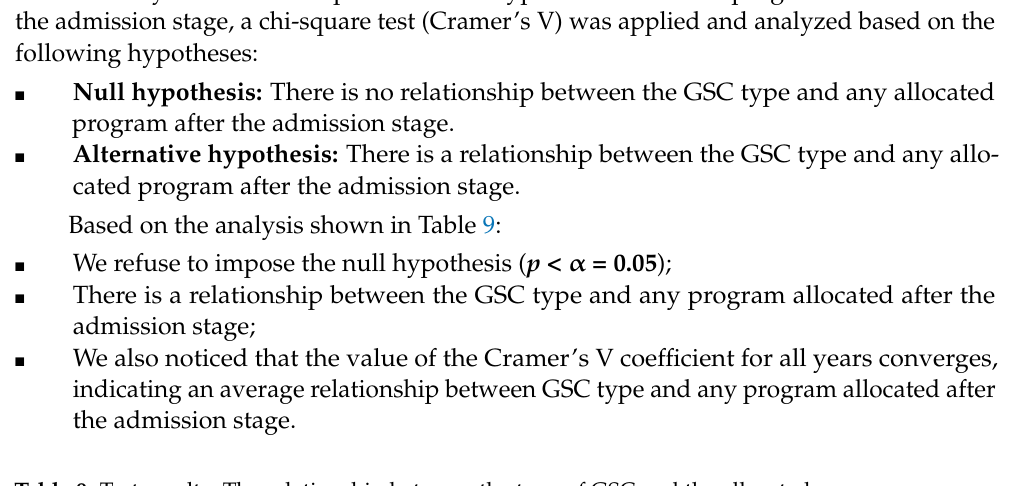
Table 9. Test results: The relationship between the type of GSC and the allocated